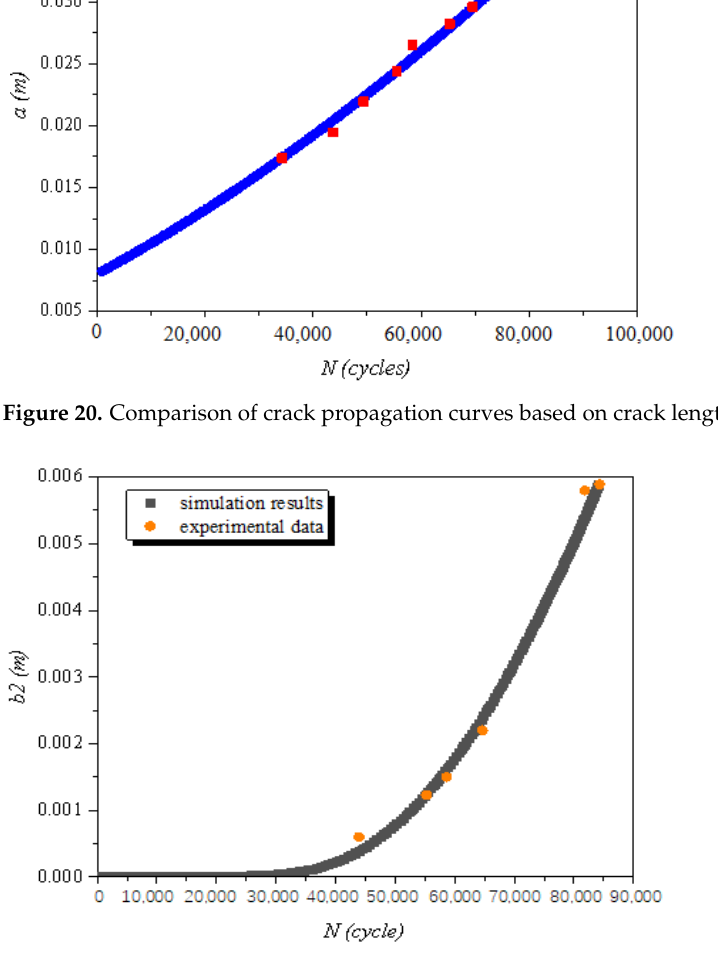
Figure 21. Comparison of crack propagation curves based on crack length b2.